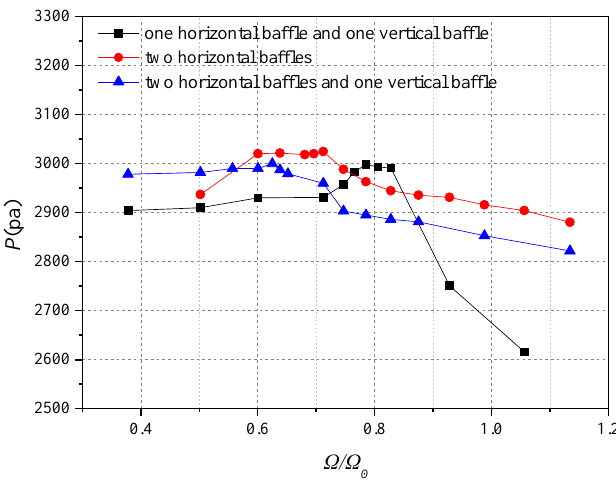
Figure 9. Comparisons of impact pressure with two horizontal and one vertical baffle, one horizontal and one vertical baffle, and two horizontal baffles only.